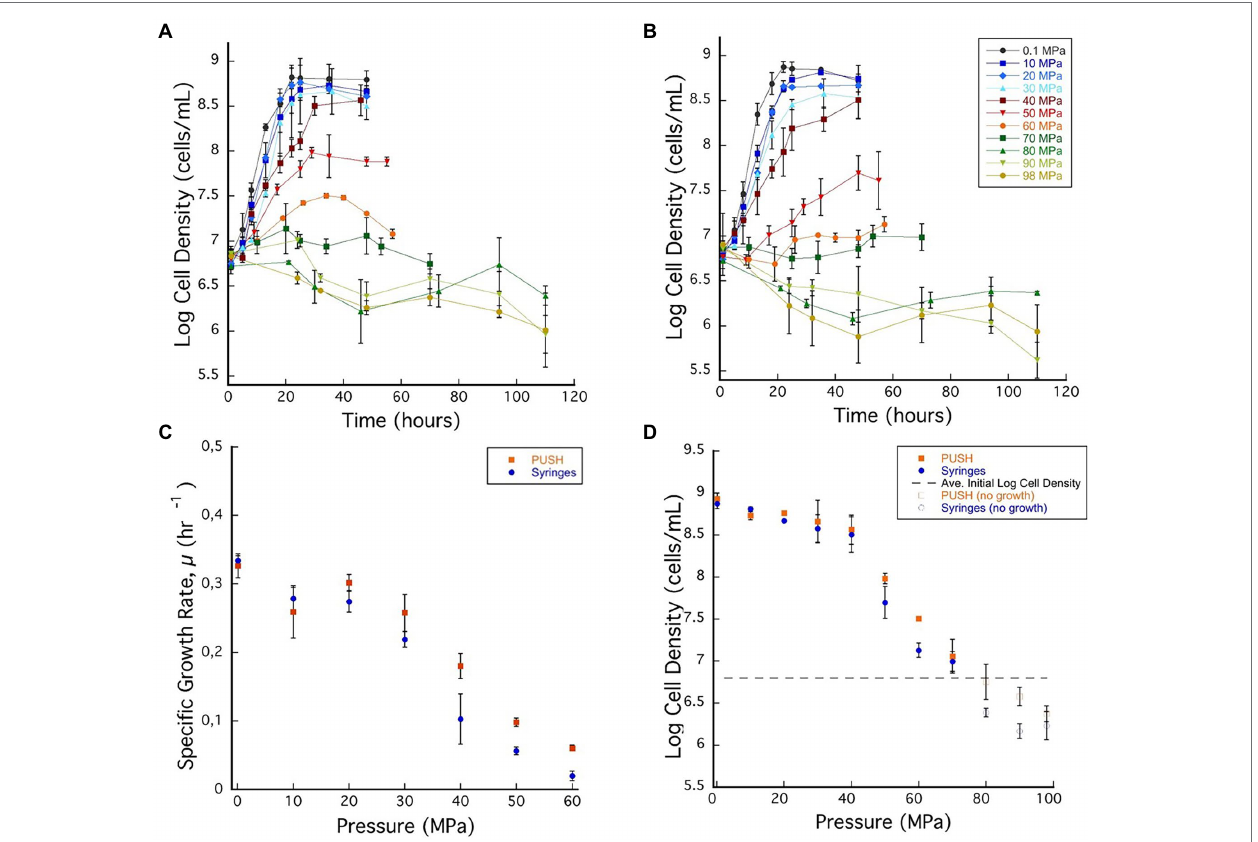
FIGURE 2 | (A) Archaeoglobus fulgidus growth curves in glass syringes with multiple sample decompression and (B) A. fulgidus growth curves in the PUSH vessels without multiple sample decompression from 0.1 to 98 MPa. (C) Archaeoglobus fulgidus specific growth rates in the PUSH vessels (orange squares) and in syringes (blue circles). (D) Archaeoglobus fulgidus maximum log cell densities in the PUSH vessels (orange squares) and in syringes (blue circles), open orange squares and blue circle indicate maximum cell densities in samples with no observed growth or observed cell densities lower than the average initial cell densities (dashed lines in D ). Error bars are the SDs from the average of triplicate experiments. Significant differences were determined by Student’s t -test (value of p <